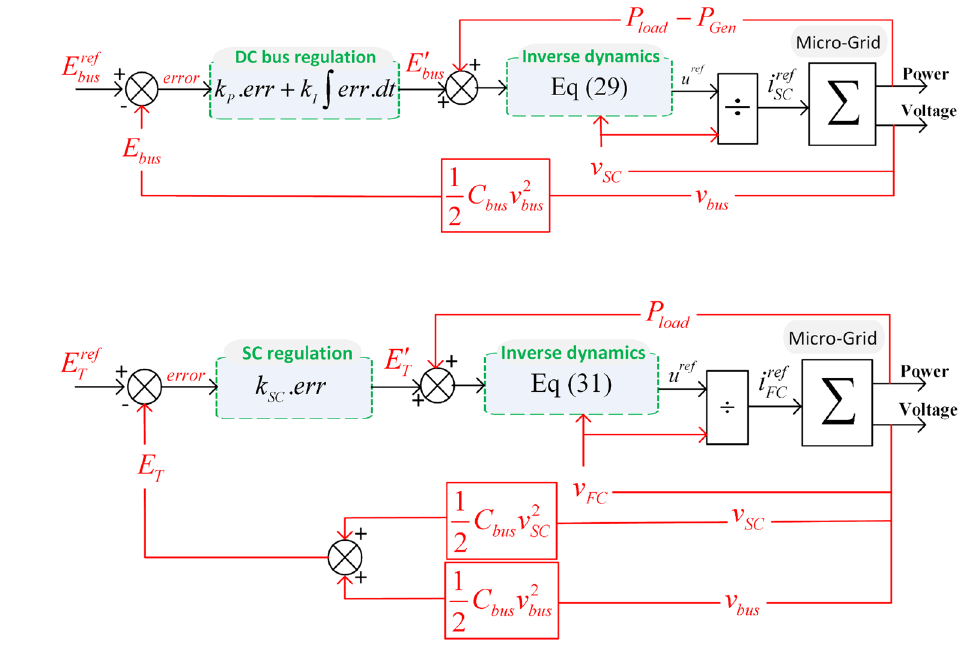
Fig. 7 The control scheme of DC bus energy